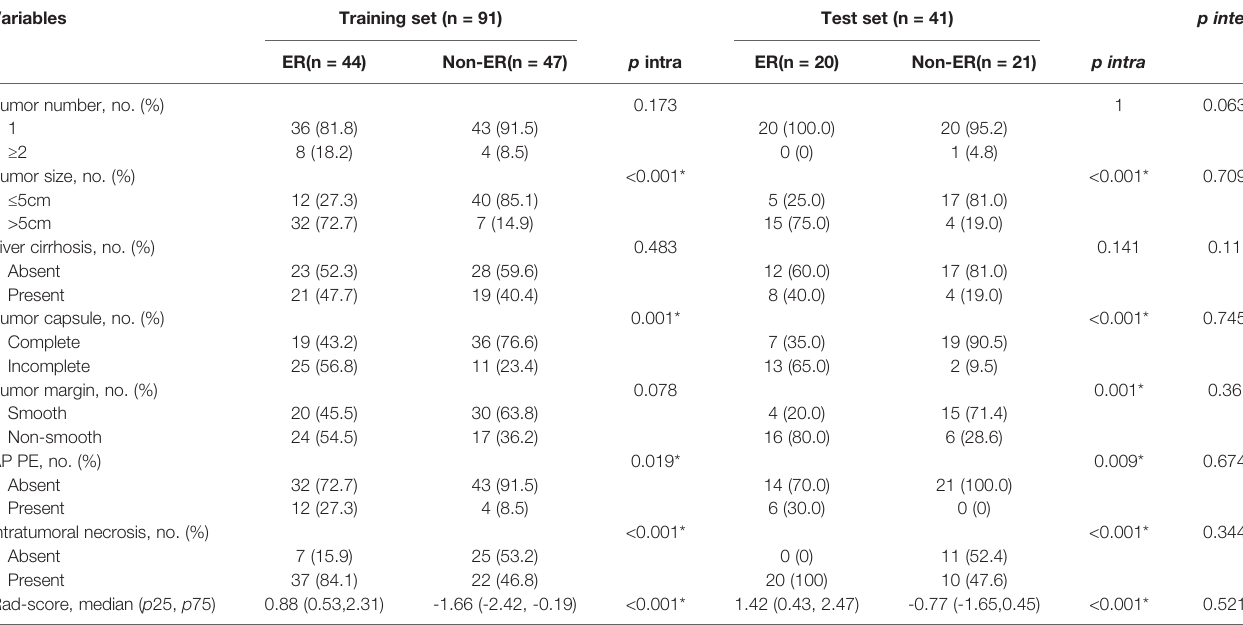
TABLE 2 | Radiological features and Rad-score of HCC patients in the training and test sets. Variables Tumor number, no. (%)